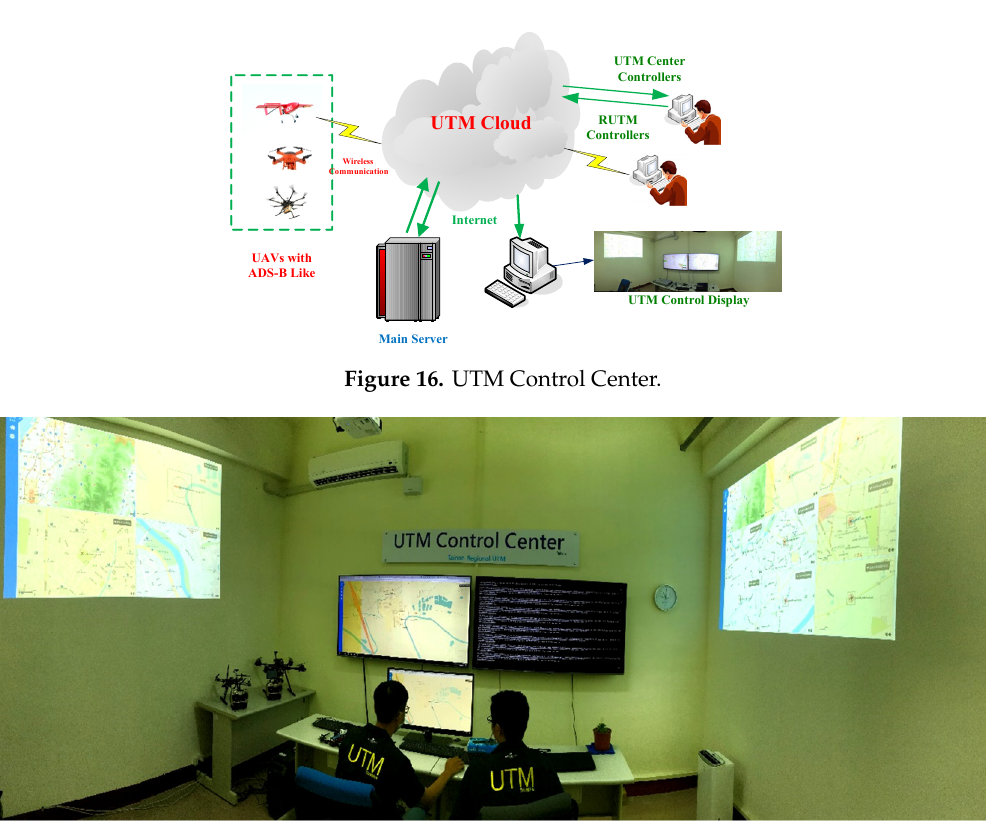
Figure 15. System redundancy using multiple ADS-B like system.